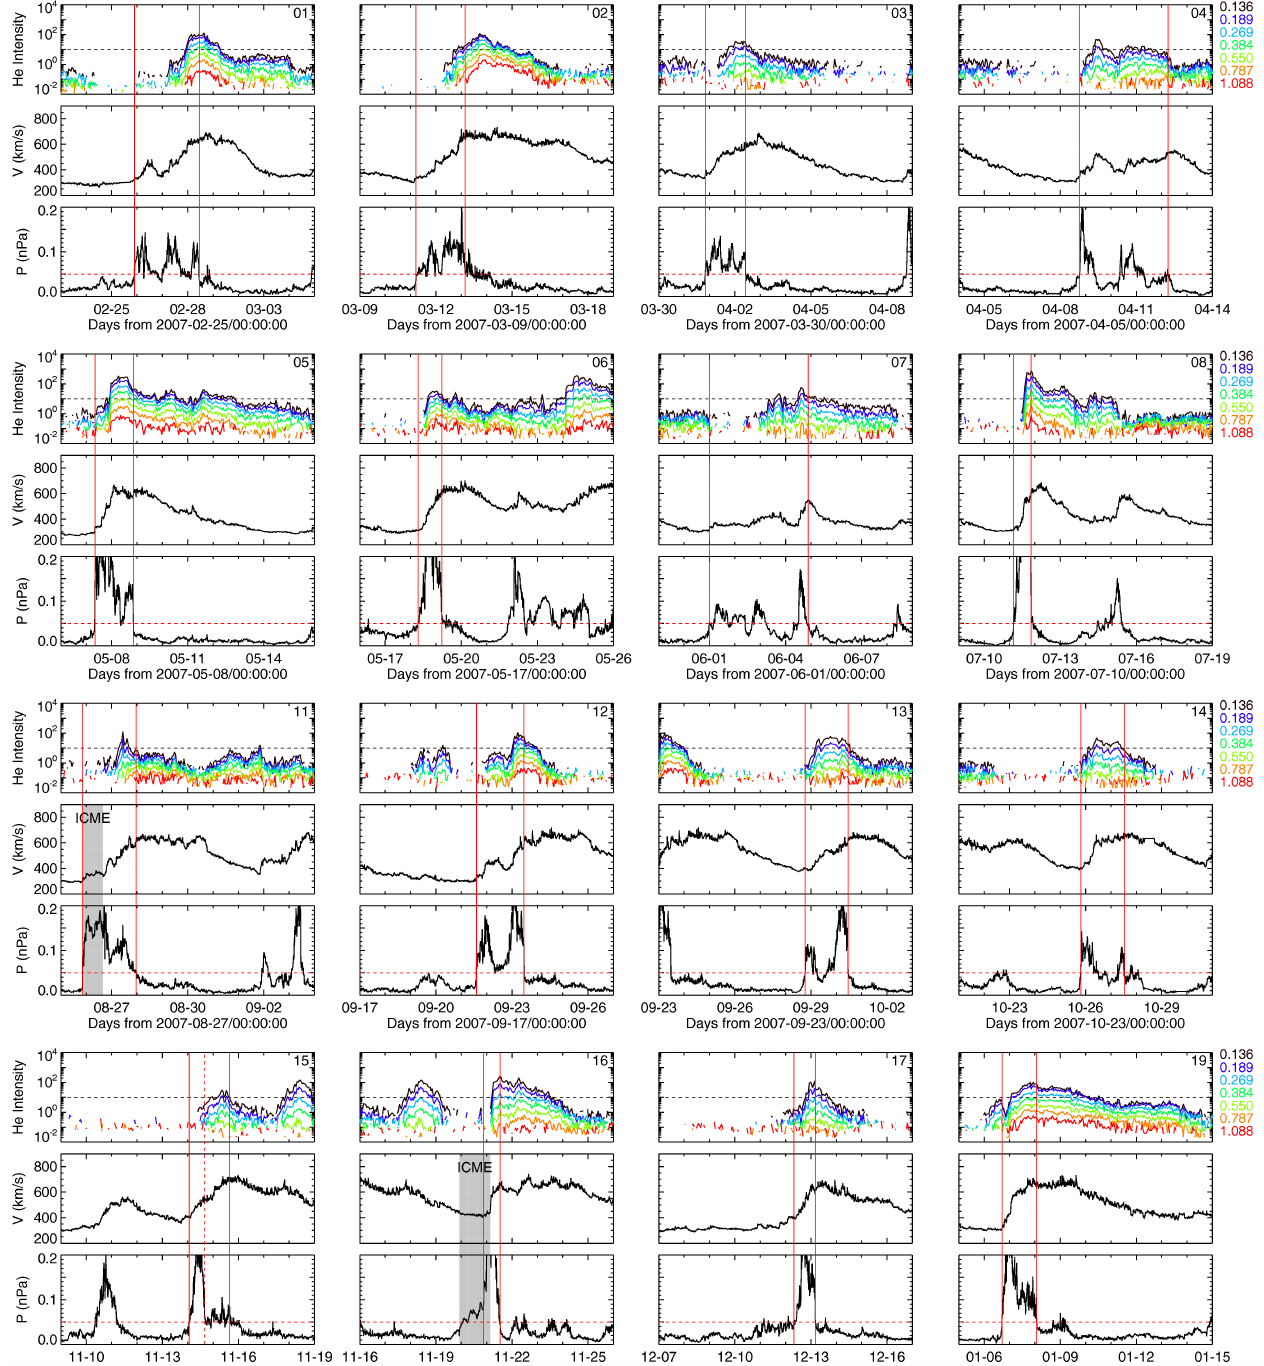
Fig. 1. STEREO-A measurements associated with the CIRs listed in Table 1. There is one subfigure for each event. The event number is displayed in the upper right corner. The subfigure contains three panels. Top panel: hourly averaged He ion intensities in seven energy channels between 0 . 136 and 1 . 088MeV / n. Middle panel: 10min averages of the solar wind speed V . Bottom panel: the total pressure P . Pairs of vertical solid lines mark CIR boundaries corresponding to the times in Table 1. The vertical dashed line marks location of the reverse shock inside the CIR. The gray shaded regions mark the time intervals of the